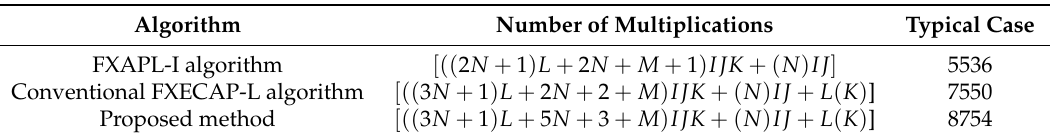
Table 1. Number of multiplications per iteration of the FXAPL-I algorithm, the conventional FXECAP-L